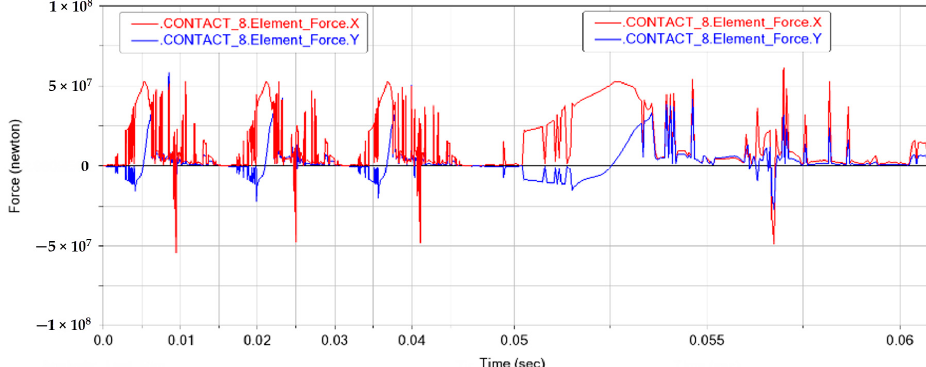
Figure 20. Second crank pin tangent (Y)/diameter (X) direction force curve.